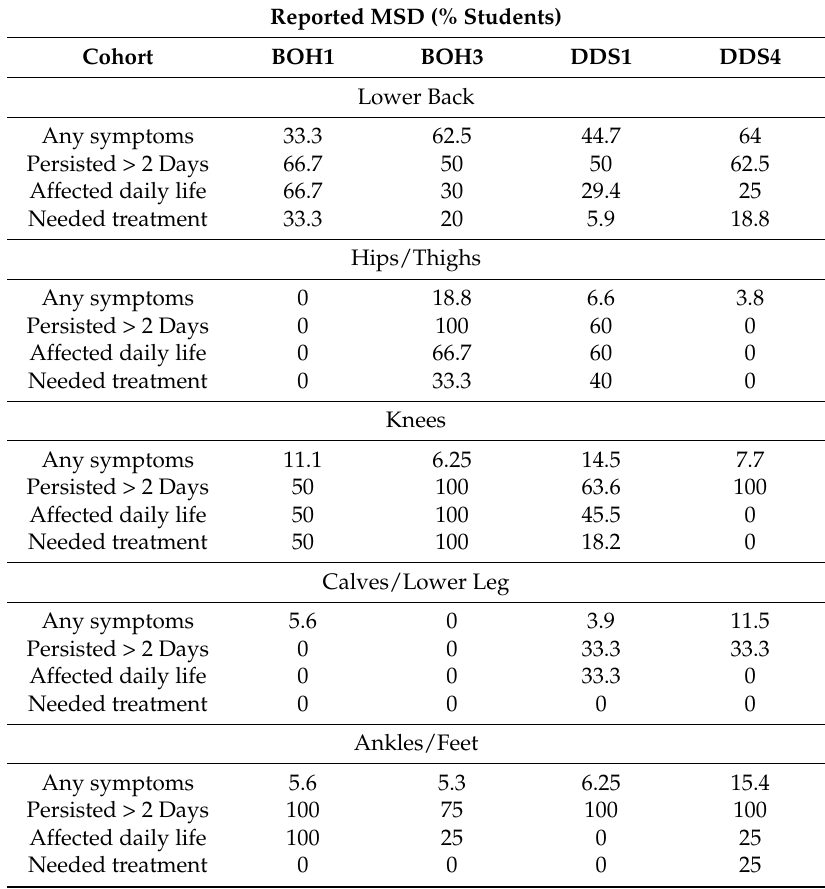
Table 5. Prevalence of MSD by lower body region.